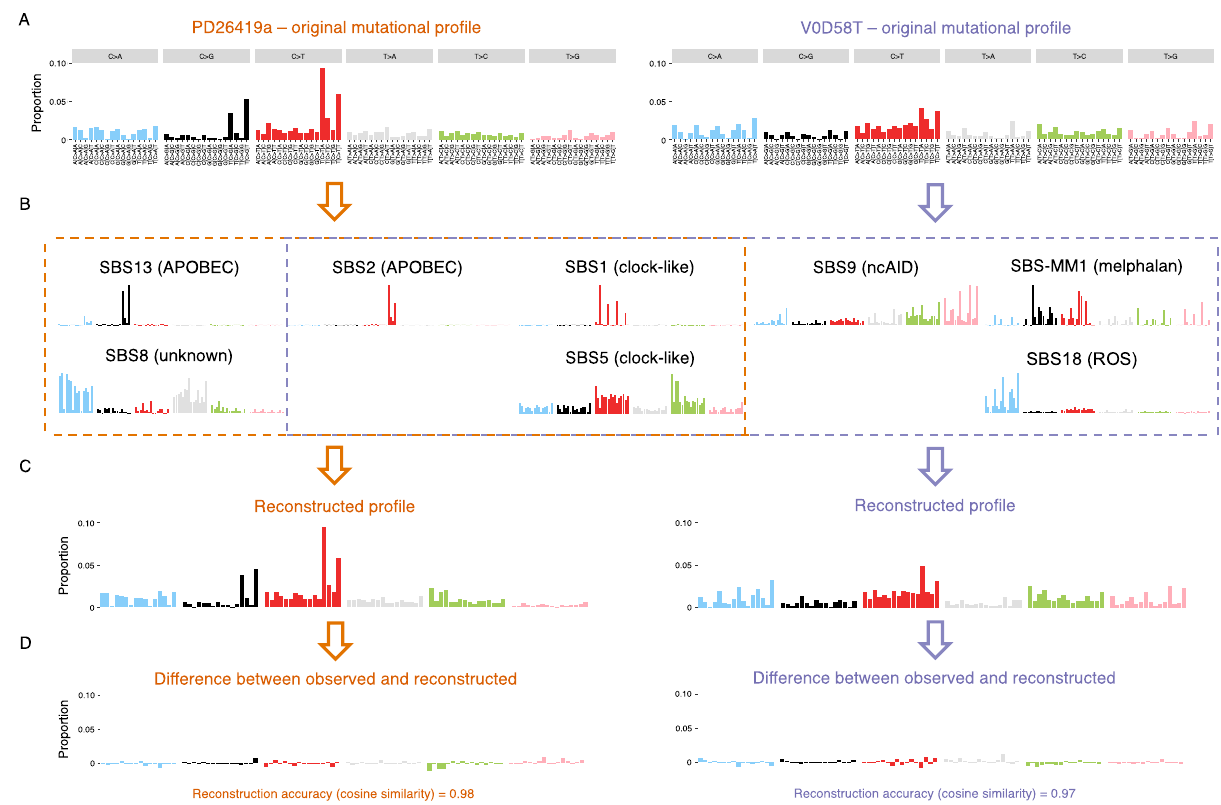
Fig. 1 Mutational fi tting in multiple myeloma. A Mutational pro fi les from two example patients with MM. B Mutational signature fi tting reveals the main APOBEC signature (SBS2) along with the clock-like signatures SBS1 and SBS5 in both samples. Sample PD26419a (left) also had evidence of SBS13, which is most often detected in patients with high APOBEC mutational burden, as well as SBS8, a common mutational signature in MM that is of unknown etiology. Sample V0D58T (right) showed contributions from non-canonical activation-induced cytidine deaminase (nc-AID; SBS9), melphalan-induced mutagenesis (SBS-MM1), and damage by reactive oxygen species (ROS; SBS18). C To measure how well the fi tted signatures account for the actual mutational pro fi le in each sample, the fi rst step is to reconstruct a mutational pro fi le by multiplying the weight assigned to each signature with the reference pro fi le of that signature. D Subtracting the reconstructed pro fi le from the original pro fi le illustrates which parts of the mutational spectrum are well-explained and may point to the presence of additional signatures that were not included in the analysis. In these cases, the mutational pro fi les were well-explained by the fi tted signatures (high reconstruction accuracy), indicated by cosine similarity of >0.97 between observed and reconstructed pro fi